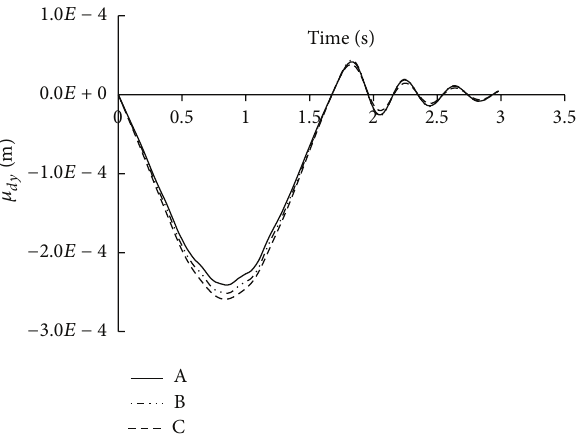
𝐼 = 6.4 × 10 7 N-m 2 , and (C) 𝐸 V V